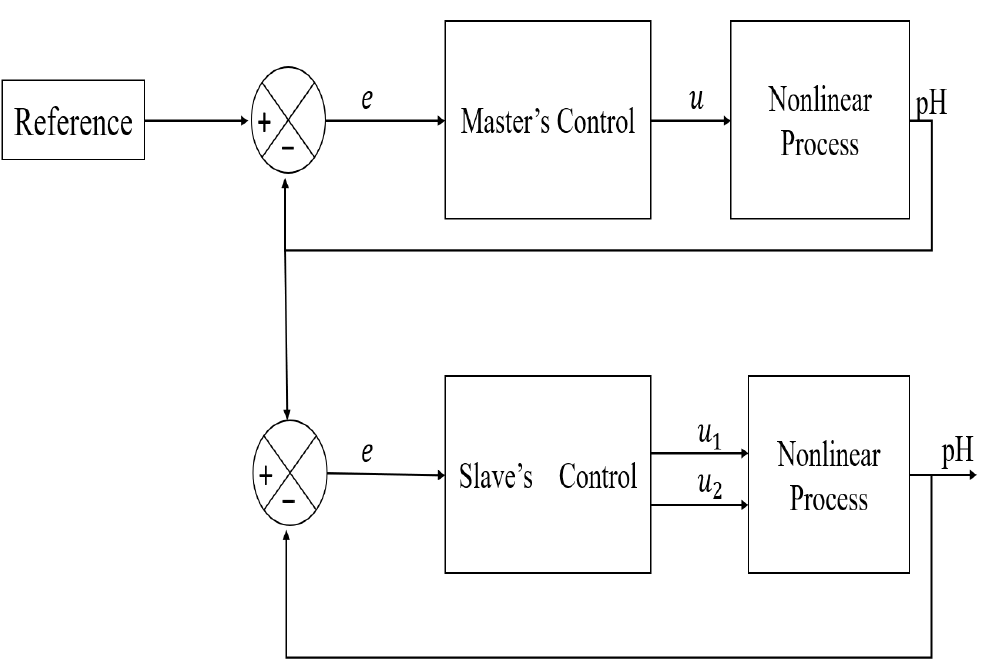
Figure 3. Control structure: master–slave synchronization in a simulation.